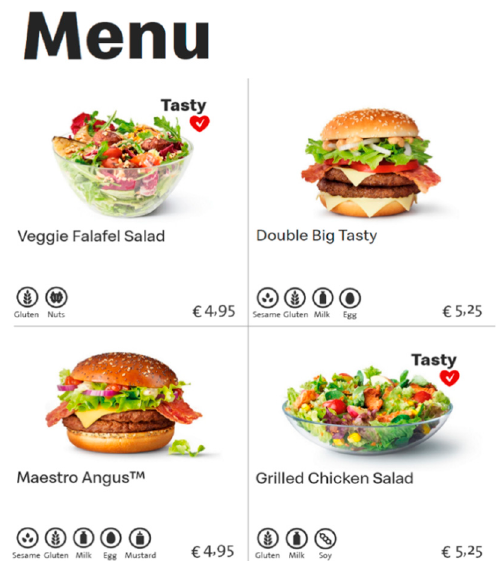
Figure 1. Condition 1: Subtle health information provided for a healthy menu product.